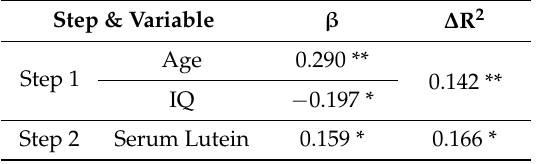
Table 4. Hierarchical linear regression modeling of object-location binding and